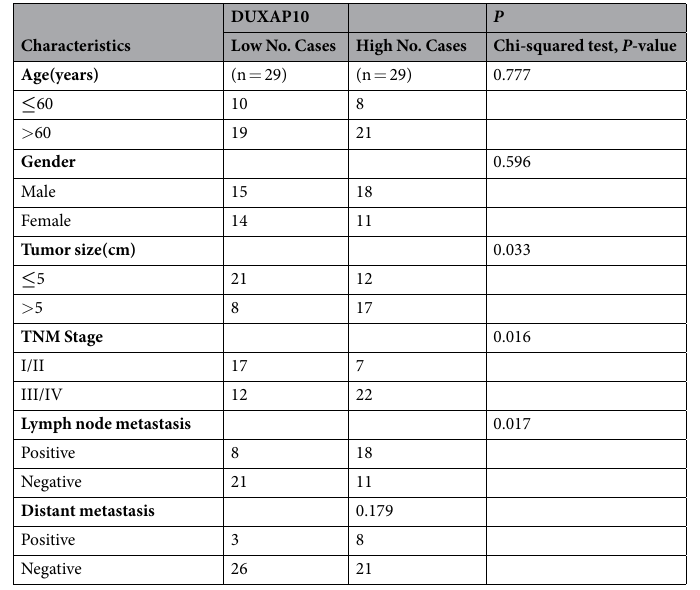
Table 1. Correlation between DUXAP10 expression and clinicopathologic characteristics of patients with CRC. (n = 58).